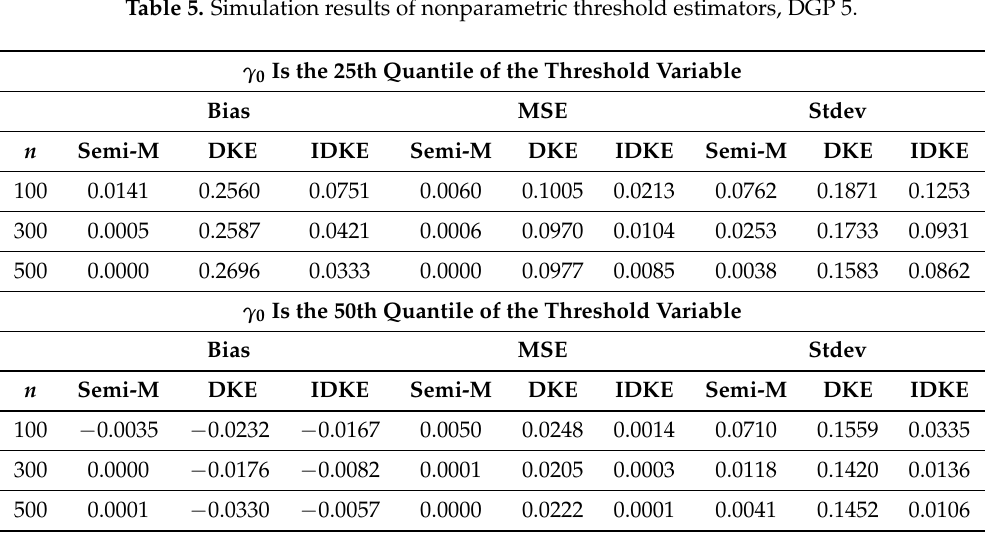
Table 5. Simulation results of nonparametric threshold estimators, DGP